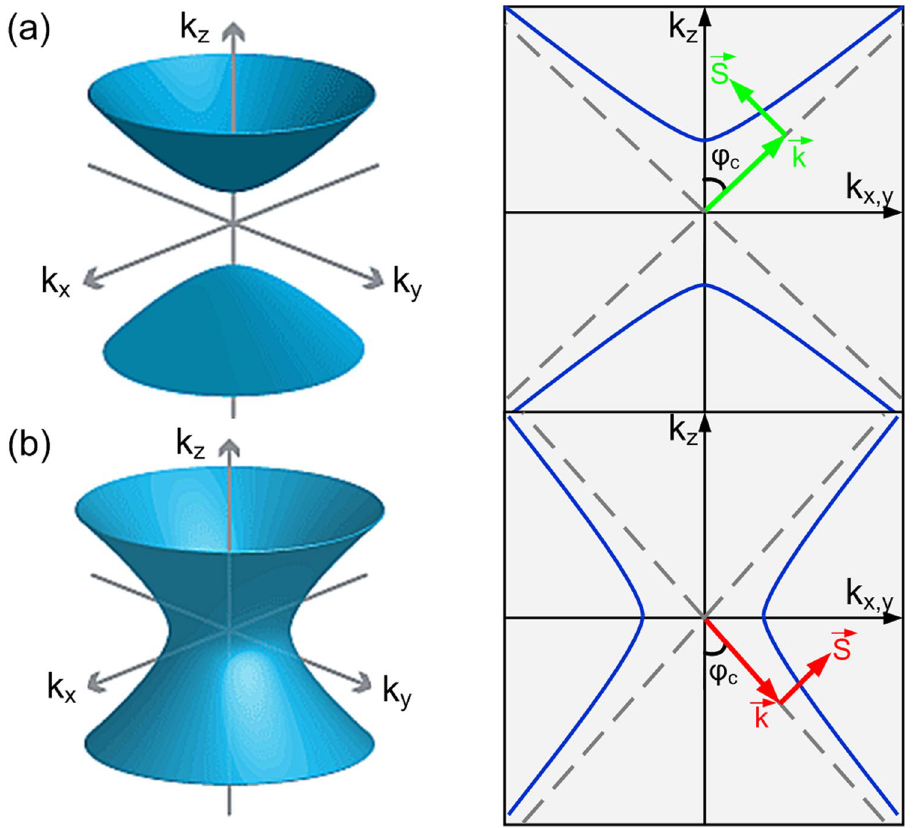
Figure 1. Optical behavior of hyperbolic media. Dispersion plots for ( a ) type I and ( b ) type II hyperbolic media. The arrows in the right column indicate the momentum (